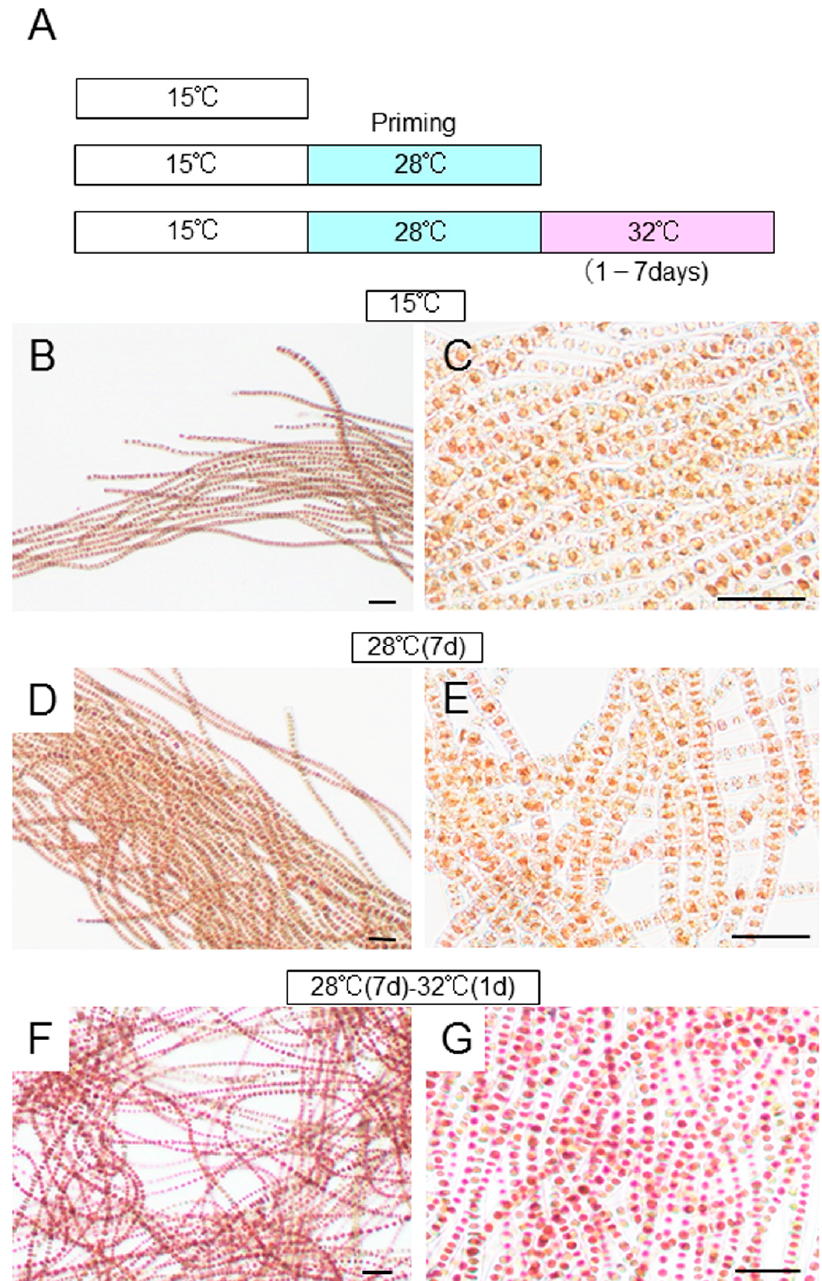
Figure 6. ‘ Bangia ’ sp. ESS2 thalli fail to acquire heat-stress tolerance: ( A ) Schematic representation of the experimental design to assess the ability of ‘ Bangia ’ sp. ESS2 to acquire heat-stress tolerance. Three temperature treatments were employed: control cultured at 15 °C, priming at 28 °C for 7 days, and treatment at 32 °C after priming for various durations from 1 to 7 days; ( B , C ) Photographs of control thalli grown at 15 °C shown at different magnifications; ( D , E ) Photographs of thalli primed at 28 °C for 7 days; ( F , G ) Photographs of thalli grown at 28 °C for 7 days, followed by 32 °C for 1 day. All thalli were stained with 0.01% erythrosine to visualize dead cells, which appear pink. Scale bars, 50 μ m.